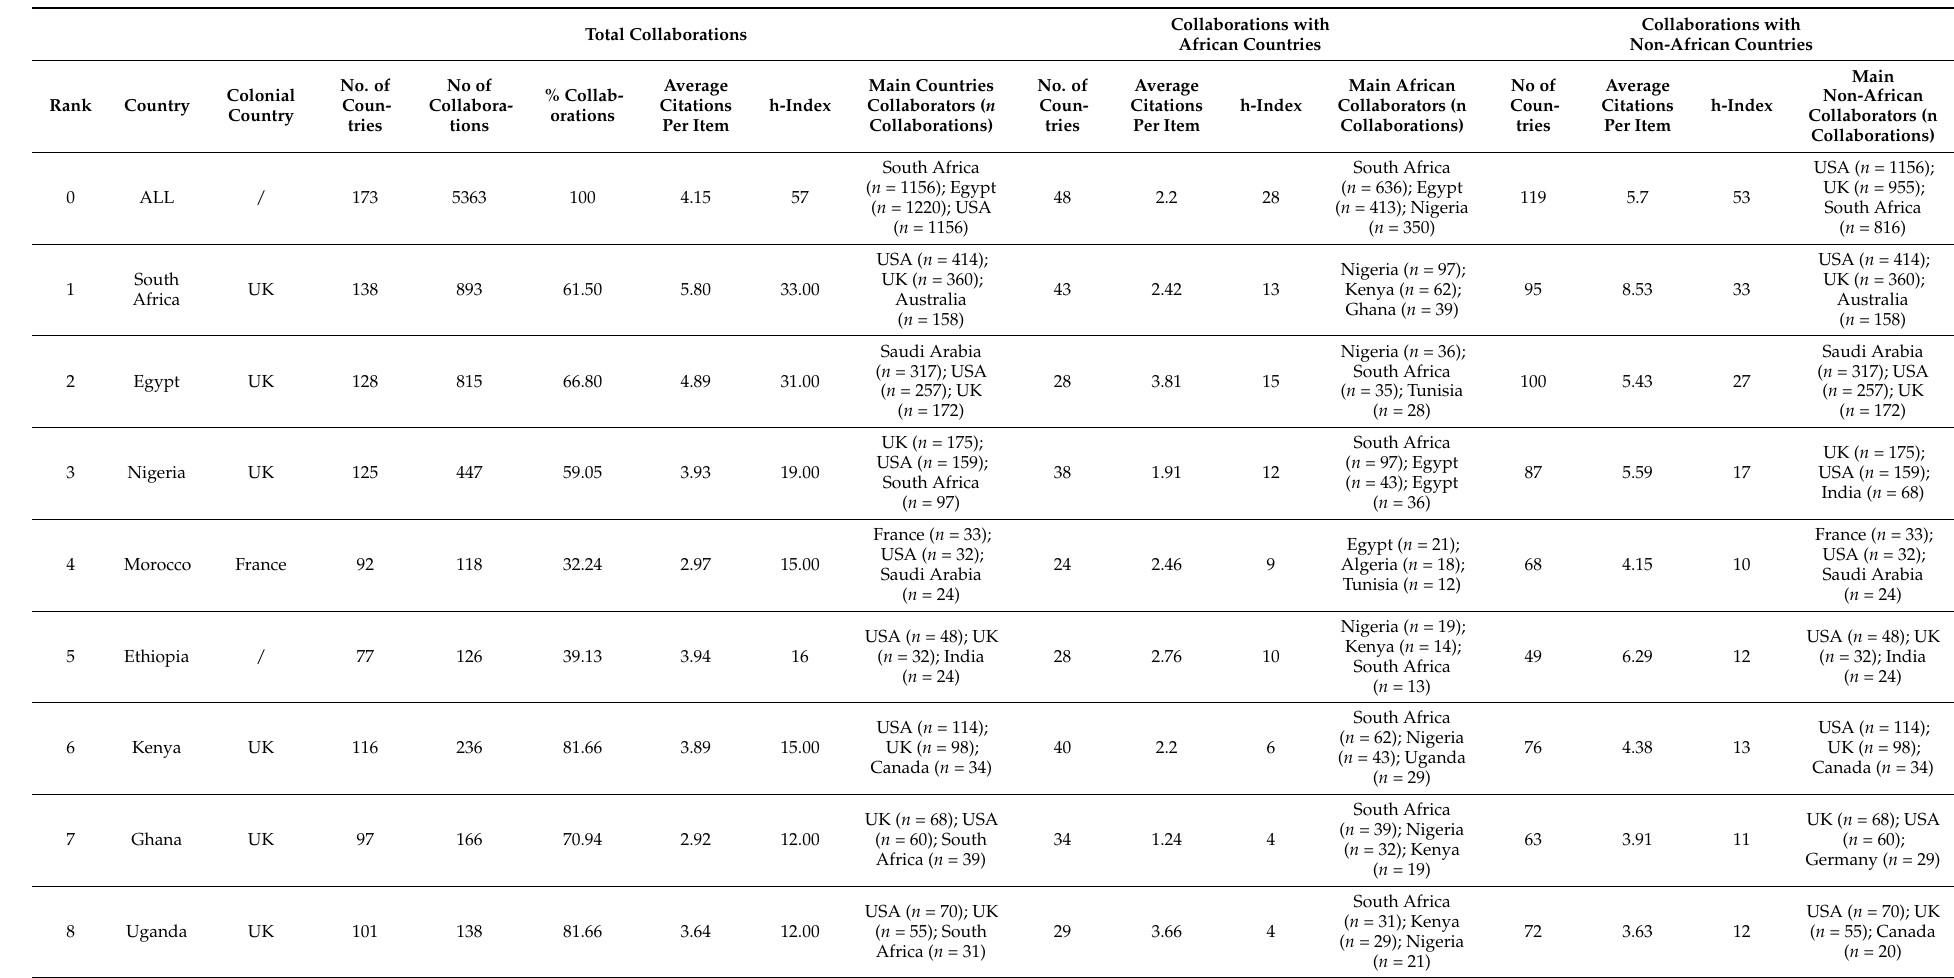
Table 3. Collaboration and leadership of top 20 African countries in research papers on